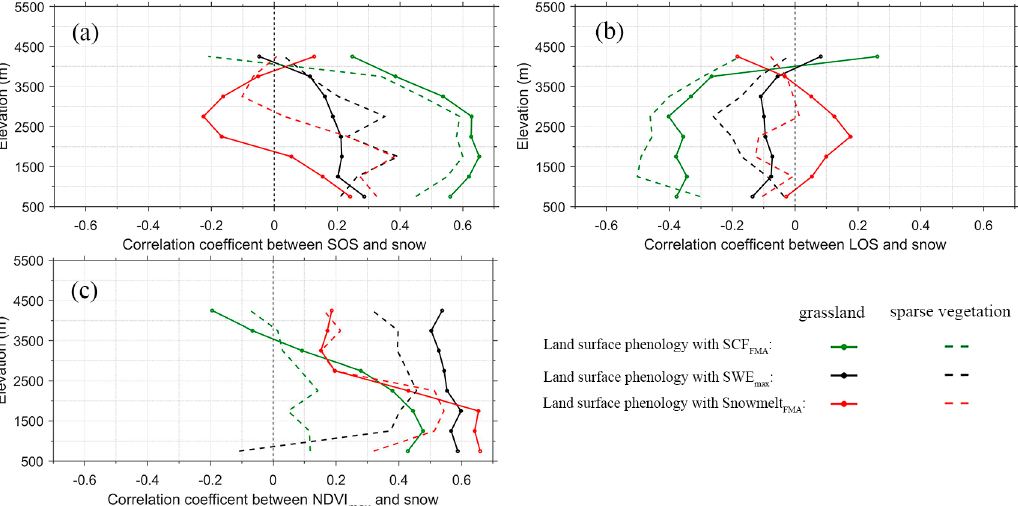
Figure 8. Elevation variation of correlation coefficients between ( a ) SOS, ( b ) LOS, and ( c ) NDVI max and SCF FMA , SWE max , and Snowmelt FMA for grassland and sparse vegetation.